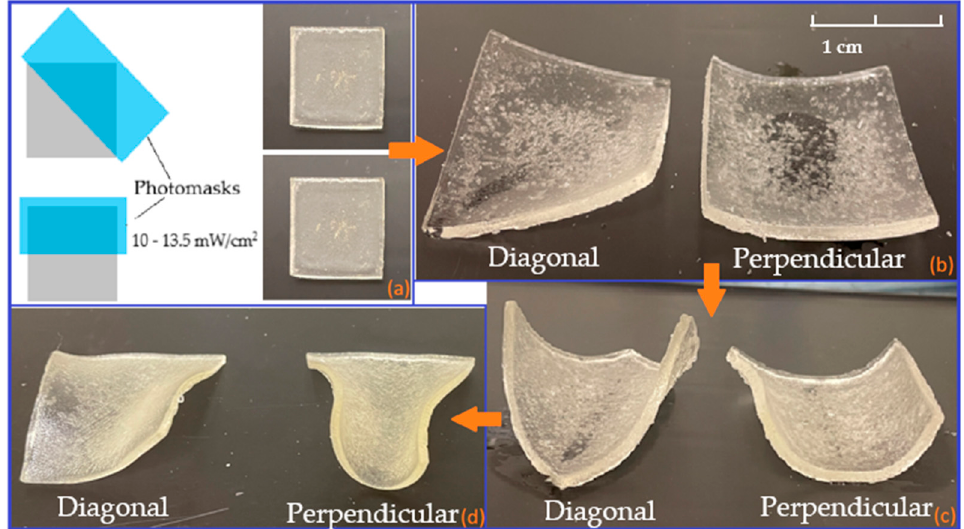
Figure 7. Monolayer squares swelling outcomes: ( a ) 0 h of swelling; ( b ) fully swollen state at ambient temperature after 72 h; ( c ) equilibrium state in the oven at 50 ◦ C after 96 h; and ( d ) equilibrium state when removed from the water for drying in the oven at 50 ◦ C after 120